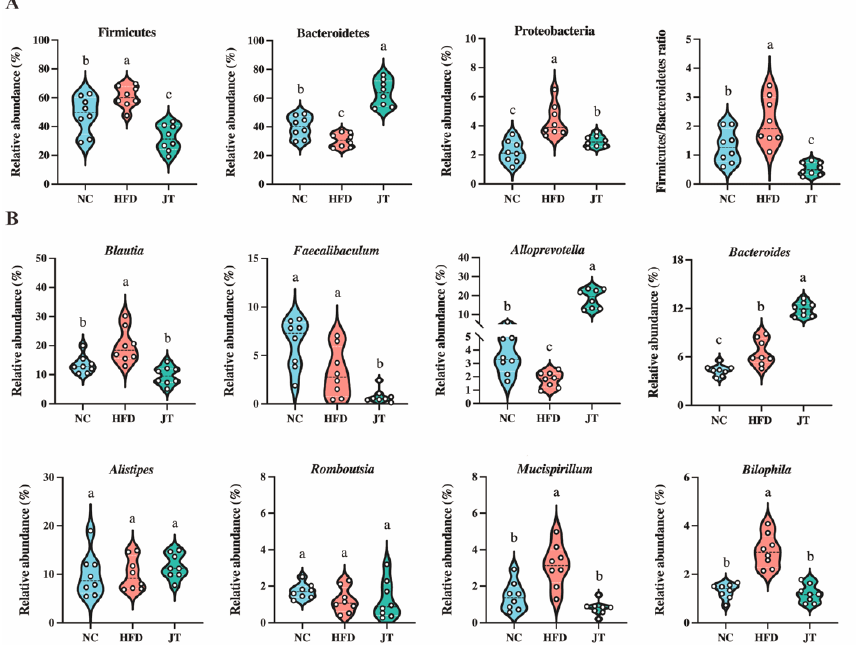
Figure 6. The abundance of predominant bacteria in intestine flora profiling of HFD-fed mice differed after CB-JT treatment. ( A ) Relative enrichment of top bacterial phyla and Firmicutes to Bacteroidetes (F/B) ratio. ( B ) Relative enrichment of dominant genera. NC: normal-chow group, HFD: high-fat diet group, JT: jasmine tea group. The mean value with different letters indicates significant differences ( p < 0.05).